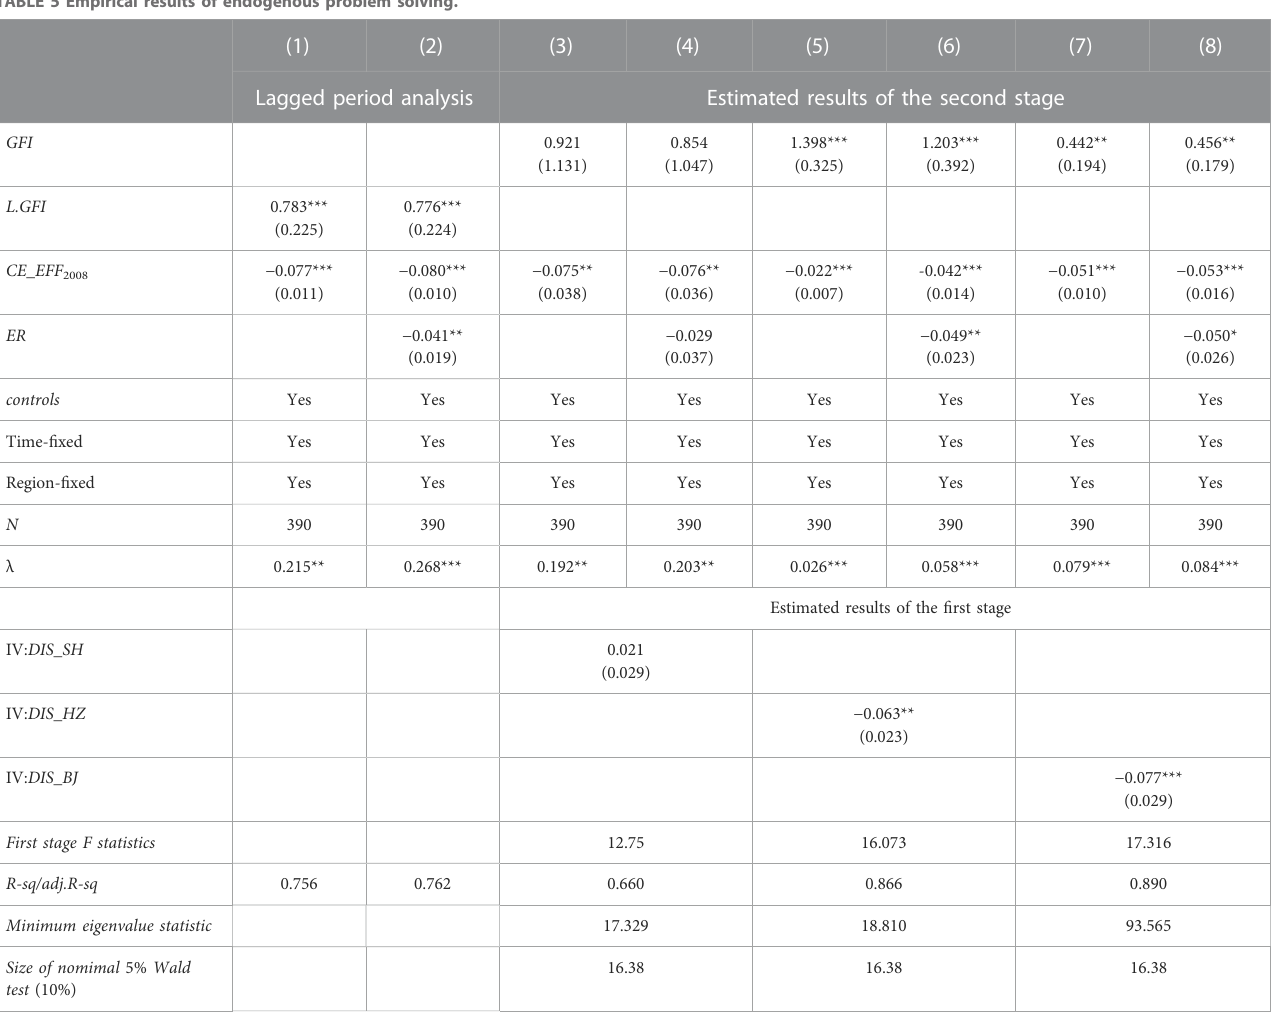
TABLE 5 Empirical results of endogenous problem